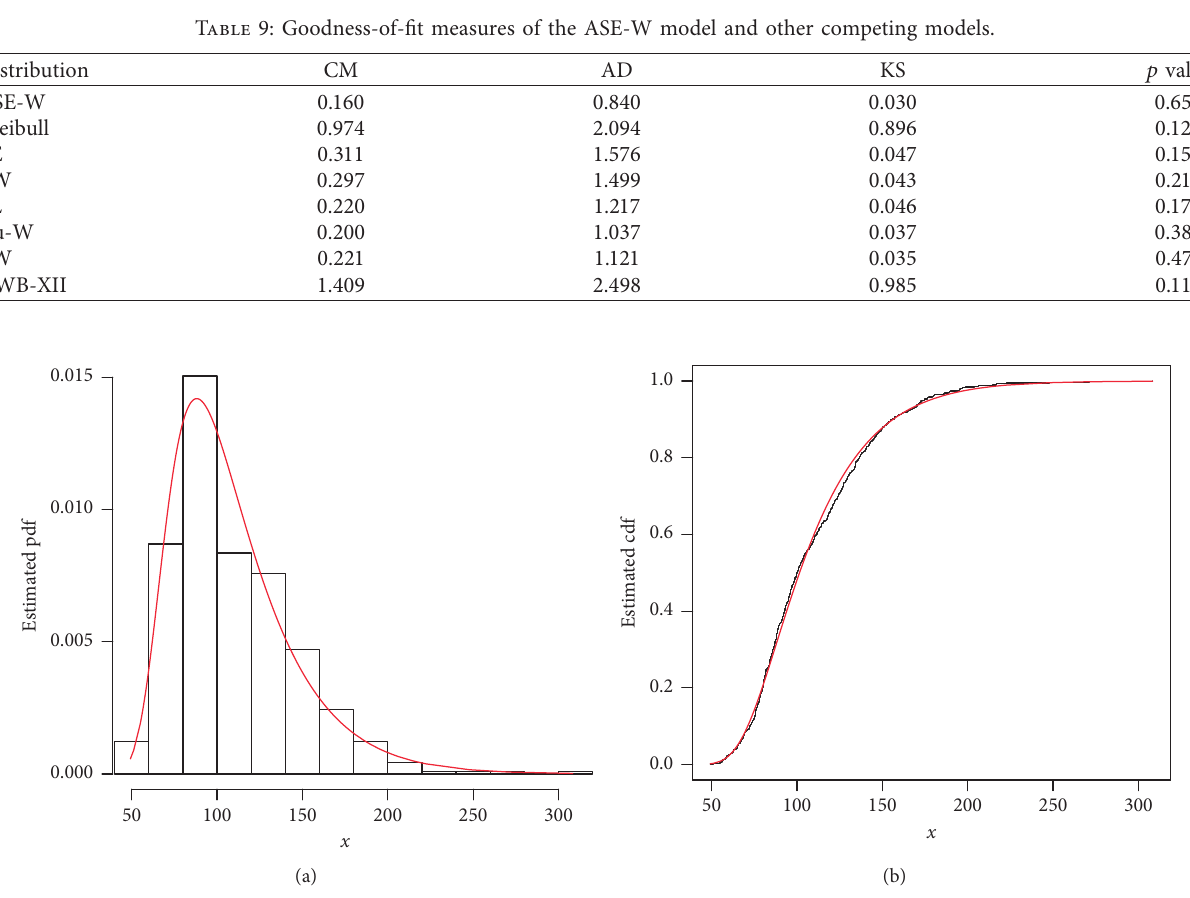
Figure 8: Estimated pdf and cdf of the ASE-W